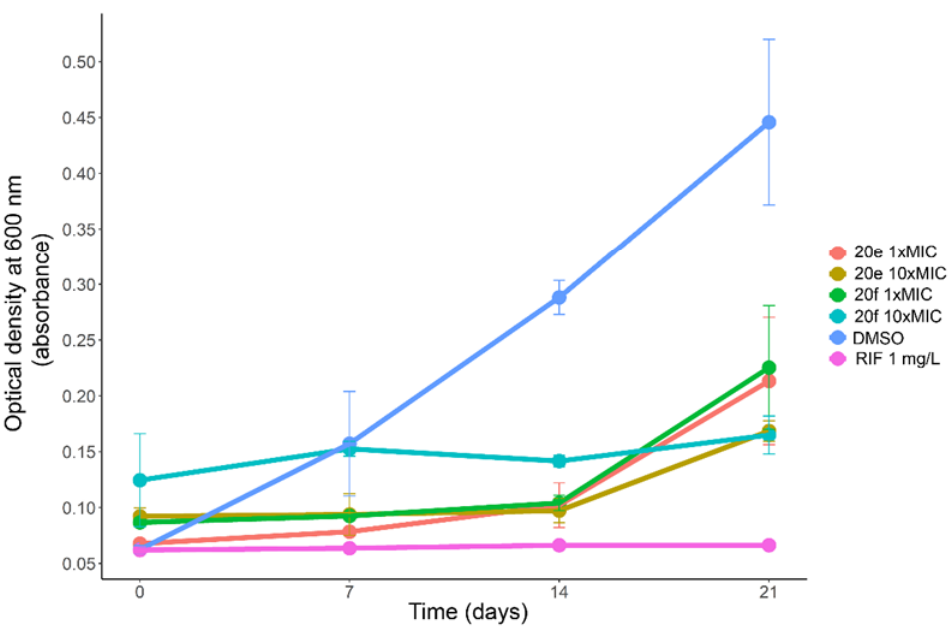
Figure 6. Growth curves of M. tuberculosis H 37 Rv in liquid media containing 1 × MIC and 10 × MIC concentrations of the compounds 20e and 20f .